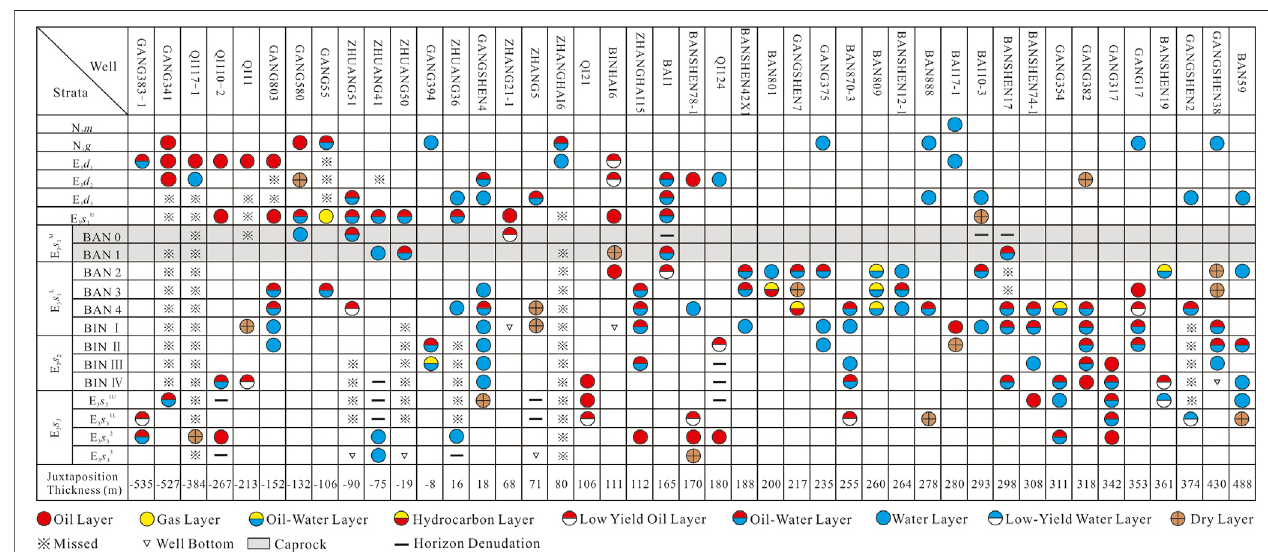
FIGURE 8 | Diagram of the determination of the maximum juxtaposition thickness required for upper and lower connection of fault-associated fracture zones in regional mudstone caprock of E 3 s 1M in Qikou Sag.